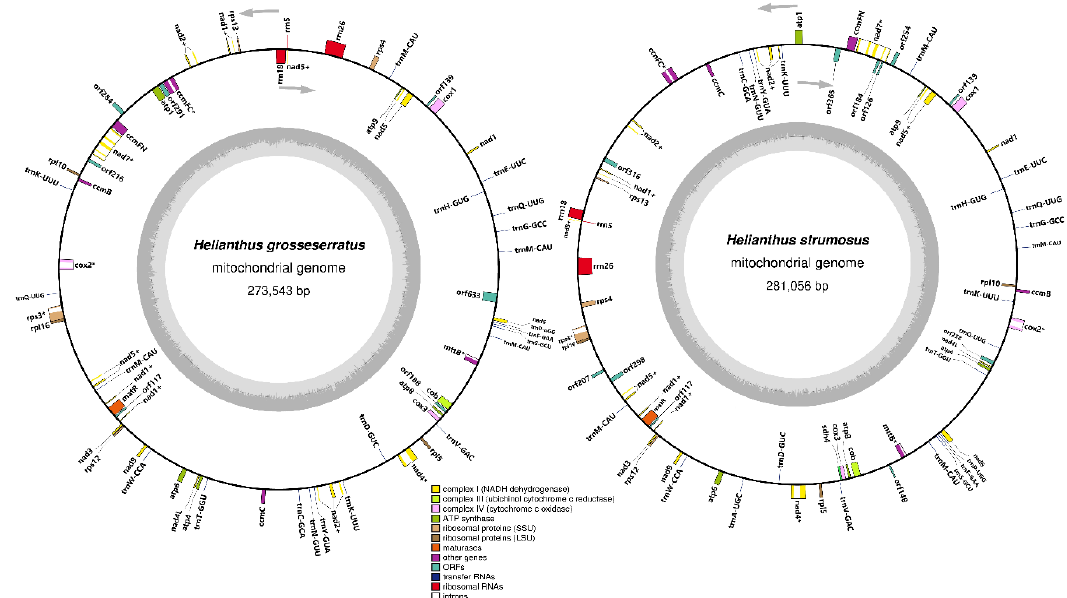
Figure 1. Mitochondrial genome maps of H. grosseserratus and H. strumosus . Arrows denote the gene's transcription orientation. Intron-containing genes are marked by an asterisk (*) symbol and trans-spliced genes—by plus ( + ) symbol.